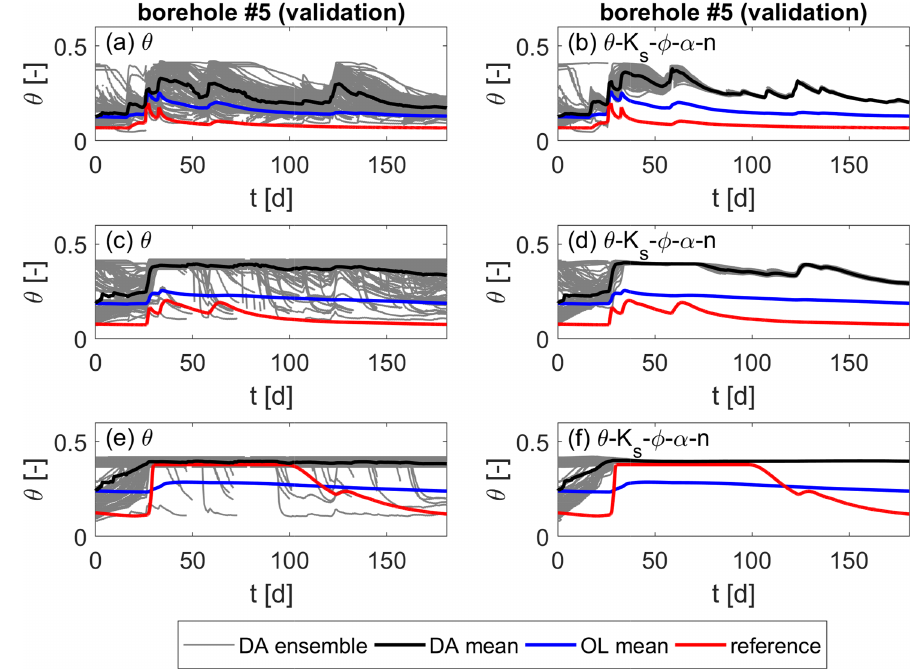
Figure 18. Soil moisture over time for the heterogeneous scenario with a simplified layered soil in the ensemble runs at one validation location. Values are taken at z 1 = 0 . 33m, z 2 = 0 . 75m, and z 3 = 0 . 95m below the surface from top to bottom. (a, c, e) Updates of soil moisture only. (b, d, f) Joint updates of soil moisture and all